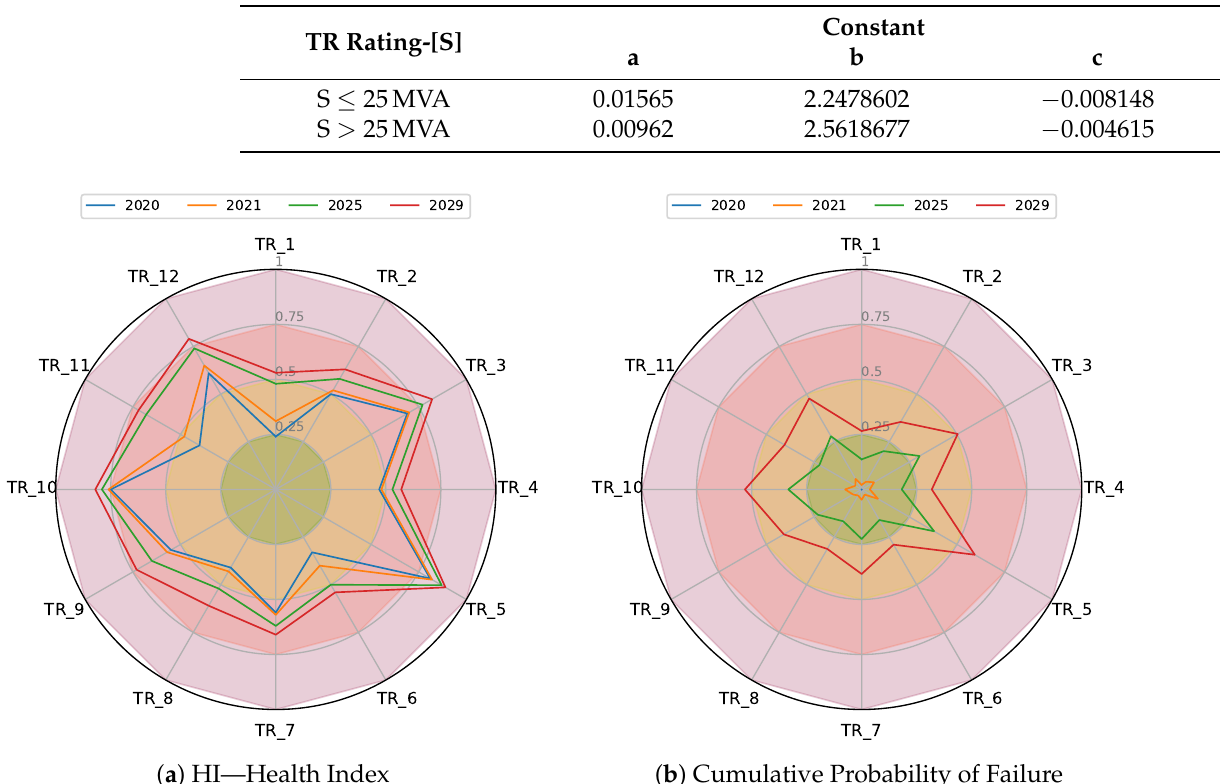
Figure 7. Health index prediction and cumulative probability forecast of failure for the transformer